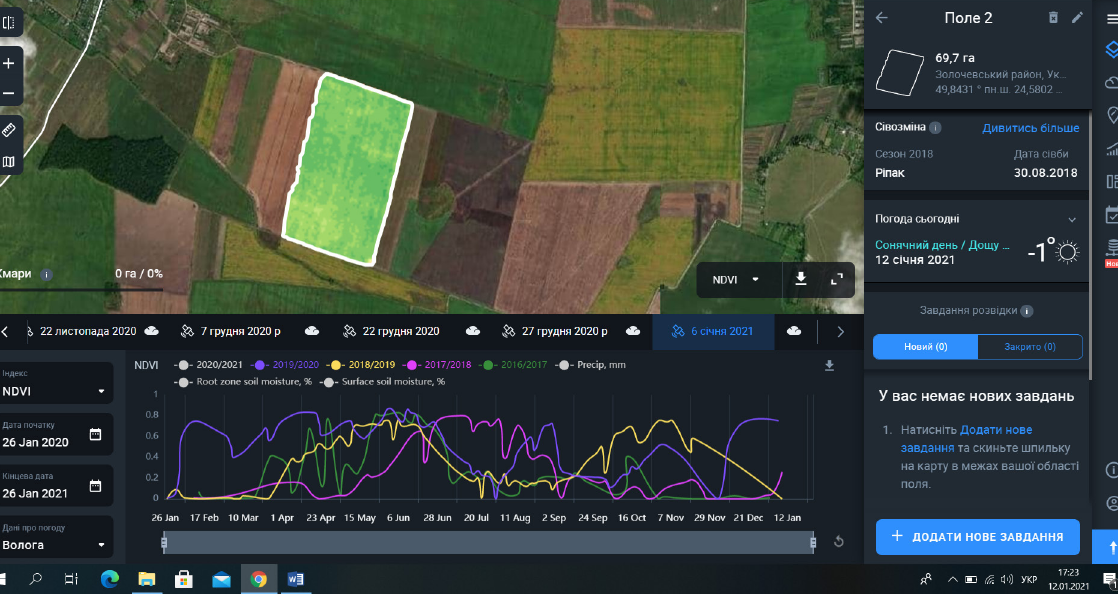
Figure 10. Dynamics of NDVI when comparing the cultivation of winter cereals in the neighboring area for land use study during